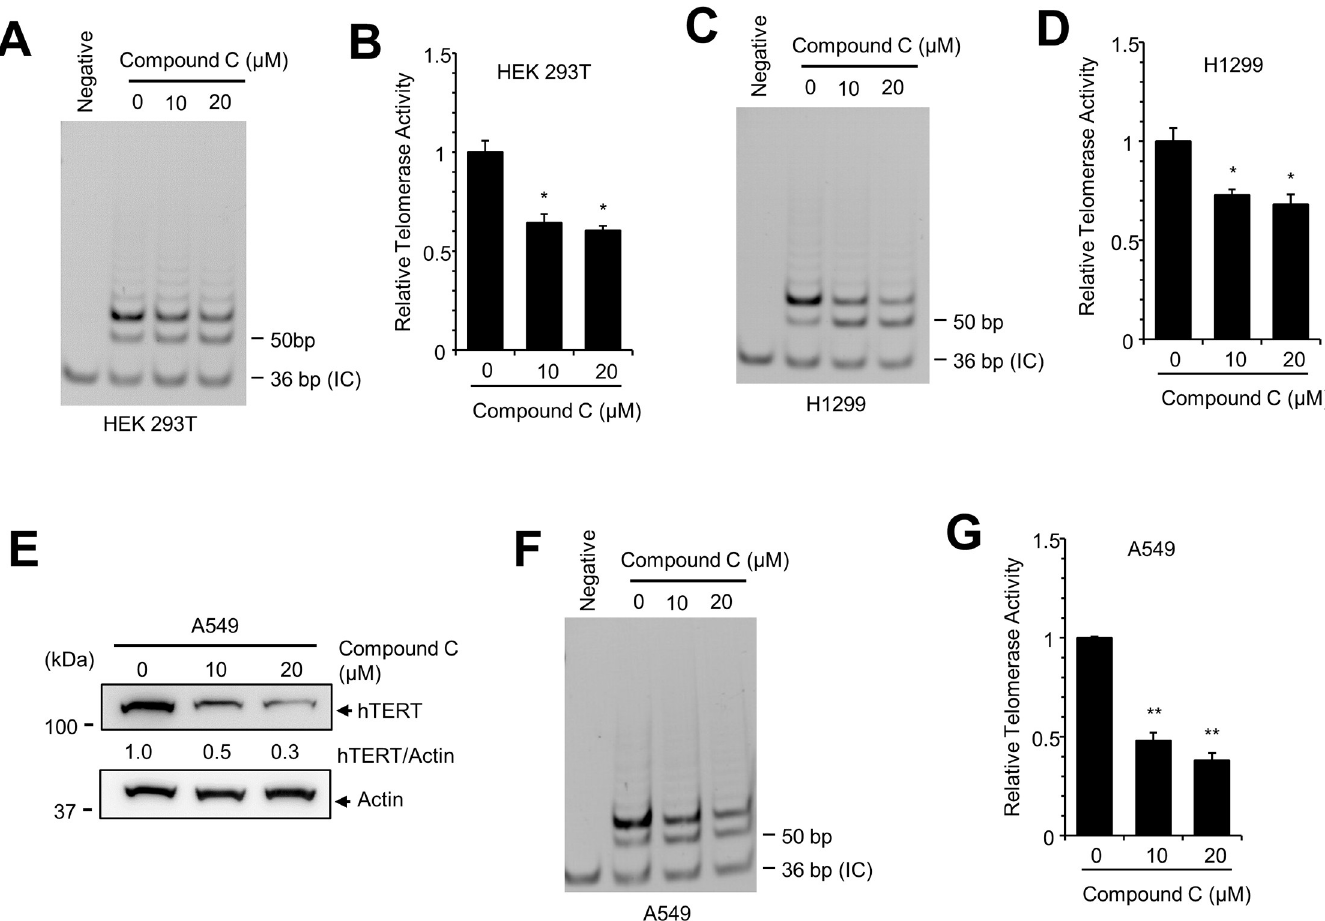
Fig 5. Compound C treatment reduces telomerase activity. ( A ) HEK293T cells were treated with indicated concentrations of compound C for 12 h. Cell lysates were prepared and assayed by TRAP analyses. The 36-bp band represents the internal TRAP assay standards (IC, internal control). ( B ) PCR-amplified extension products were quantified to measure the telomerase activity. ( C, D ) TRAP analysis of H1299 cells. ( E ) A549 cells were treated with the indicated concentrations of compound C for 12 h, and the expression of hTERT was examined by western blotting. The level of hTERT expression was quantitated and normalized to actin expression. ( F, G ) TRAP analysis of A549 cell lysates. Control vs. drug treated, � P < 0.05, �� P < 0.005.